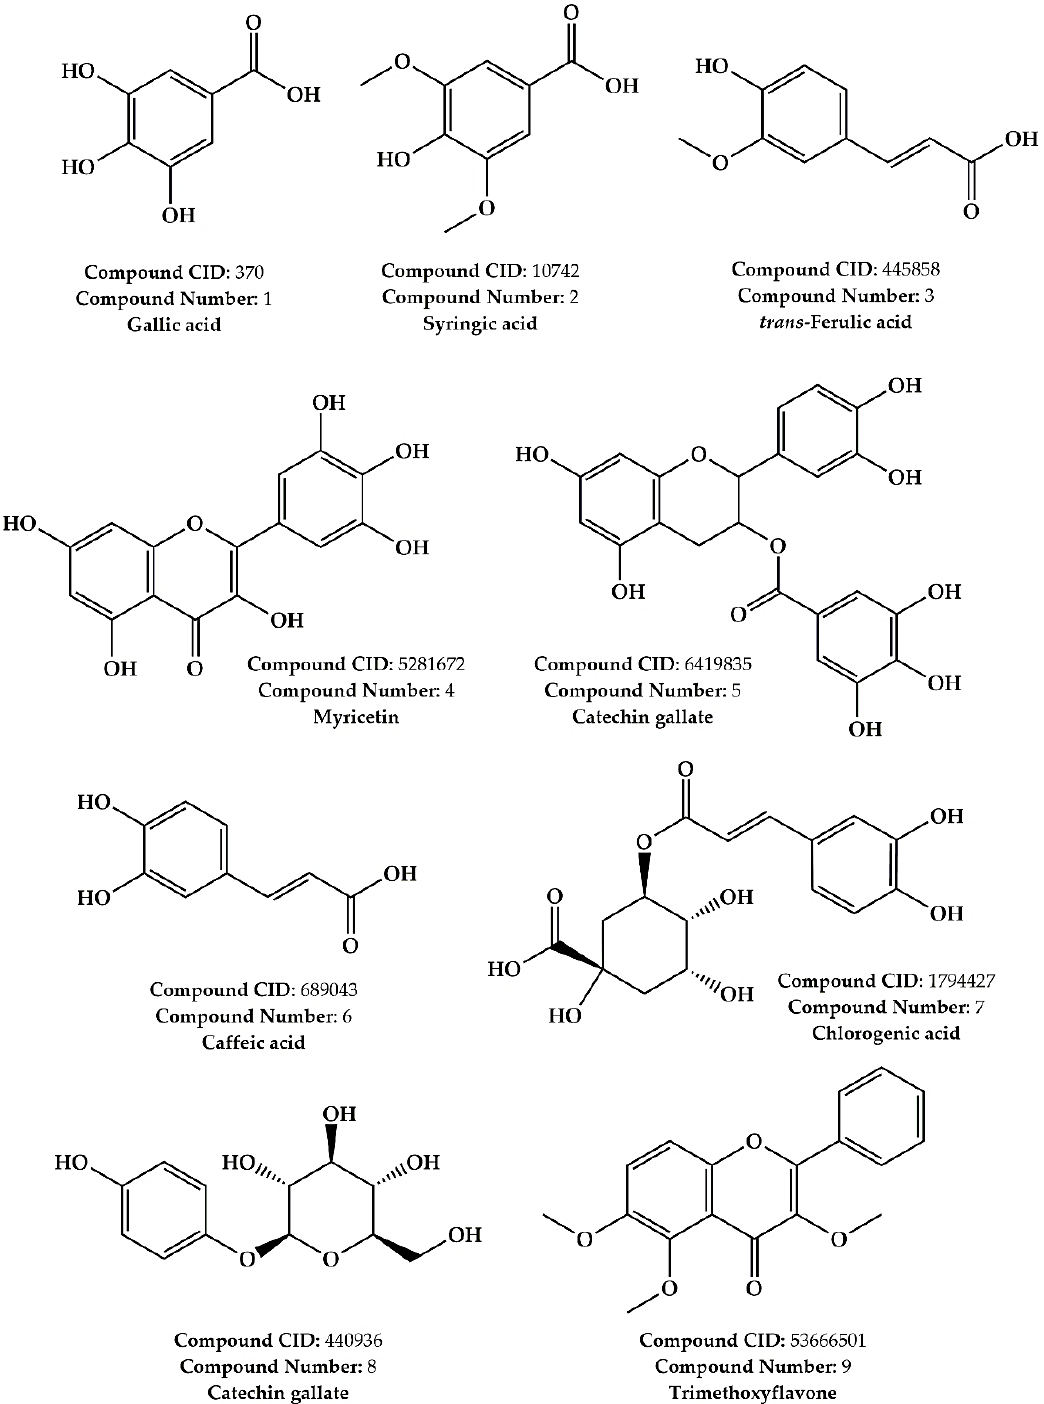
Figure 1. Chemical structures of the identified compounds in A. halimus ethanolic extract using LC –